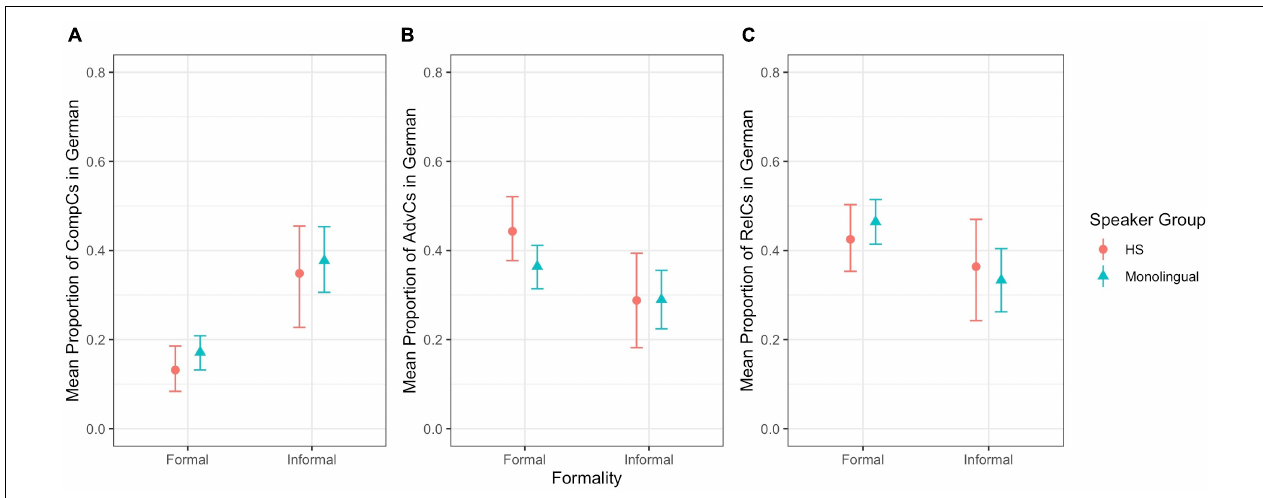
FIGURE 4 | Mean proportion of SC types in German by speaker group and formality: (A) Complement Clauses, (B) Adverbial Clauses, (C) Relative Clauses.